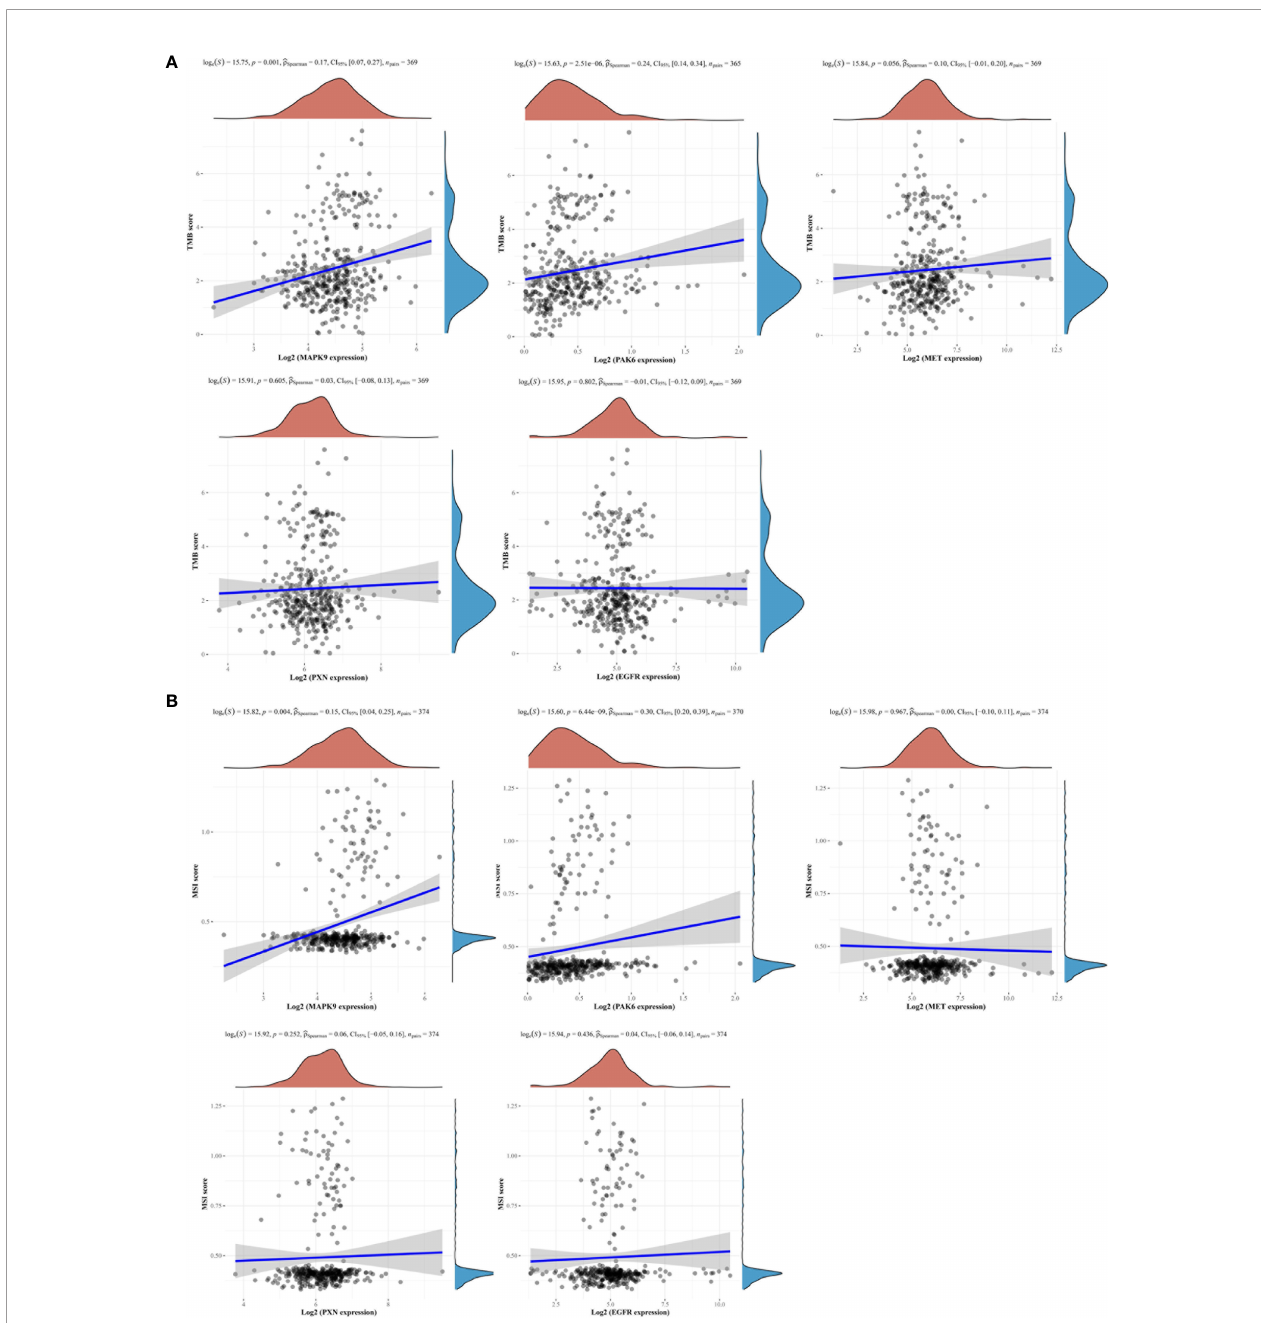
FIGURE 5 | Focal adhesion-related gene signatures and tumor mutation burden (TMB)/microsatellite instability (MSI). Two focal adhesion-related gene signatures (MAPK9, PAK6) were observed to be positively associated with the levels of TMB (A) and MSI (B)